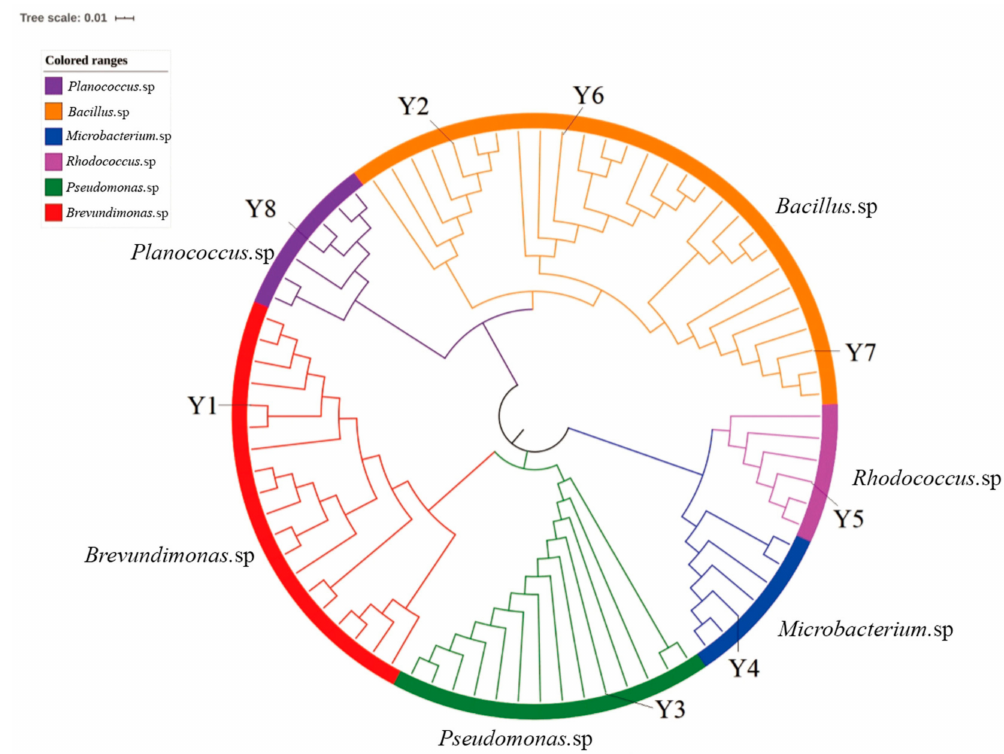
Figure 1. The phylogenetic tree based on 16S rRNA gene sequences of the isolates and related species. Neighbor-joining analysis with 1000 bootstrap replicates was used to infer tree topology. The bar represents 0.1% sequence divergence. Sequenced data showing the location of selected isolated